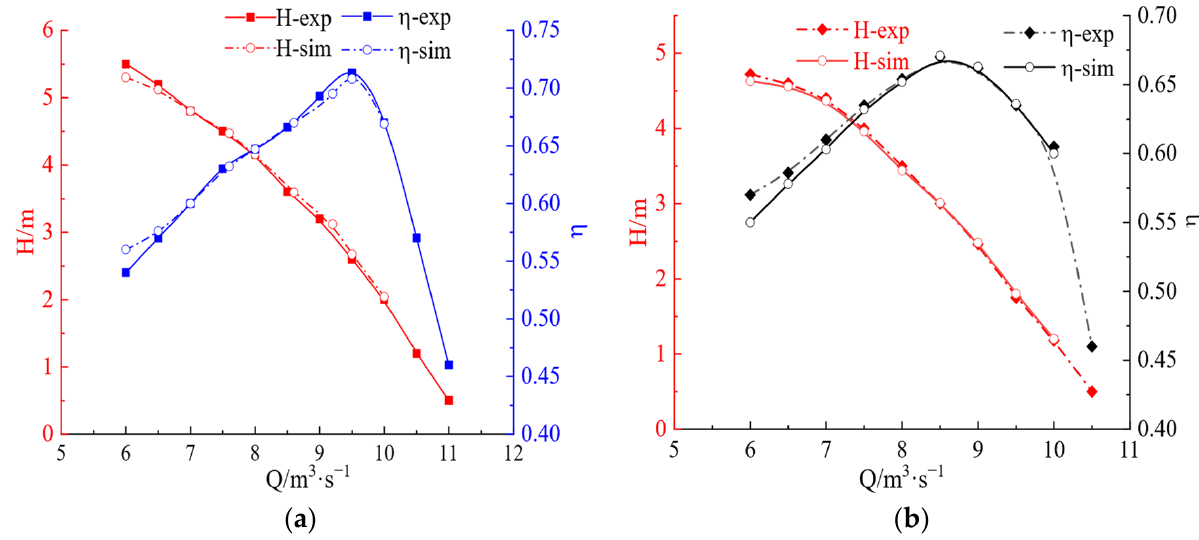
Figure 6. ( a ) Forward characteristic curve. ( b ) Inverse characteristic curve.